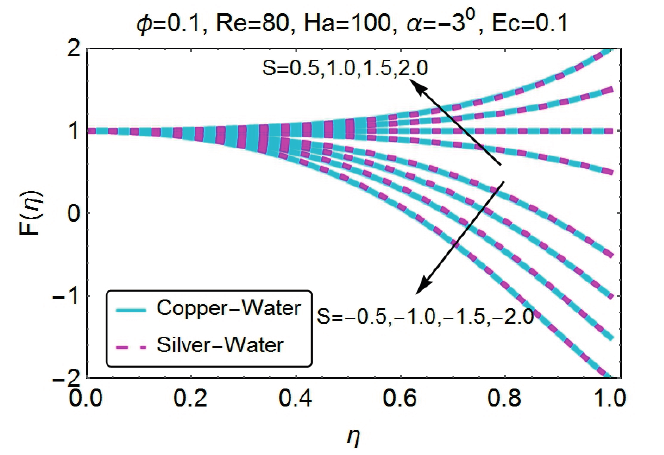
Figure 10. Change in velocity for varying S (divergent channel).